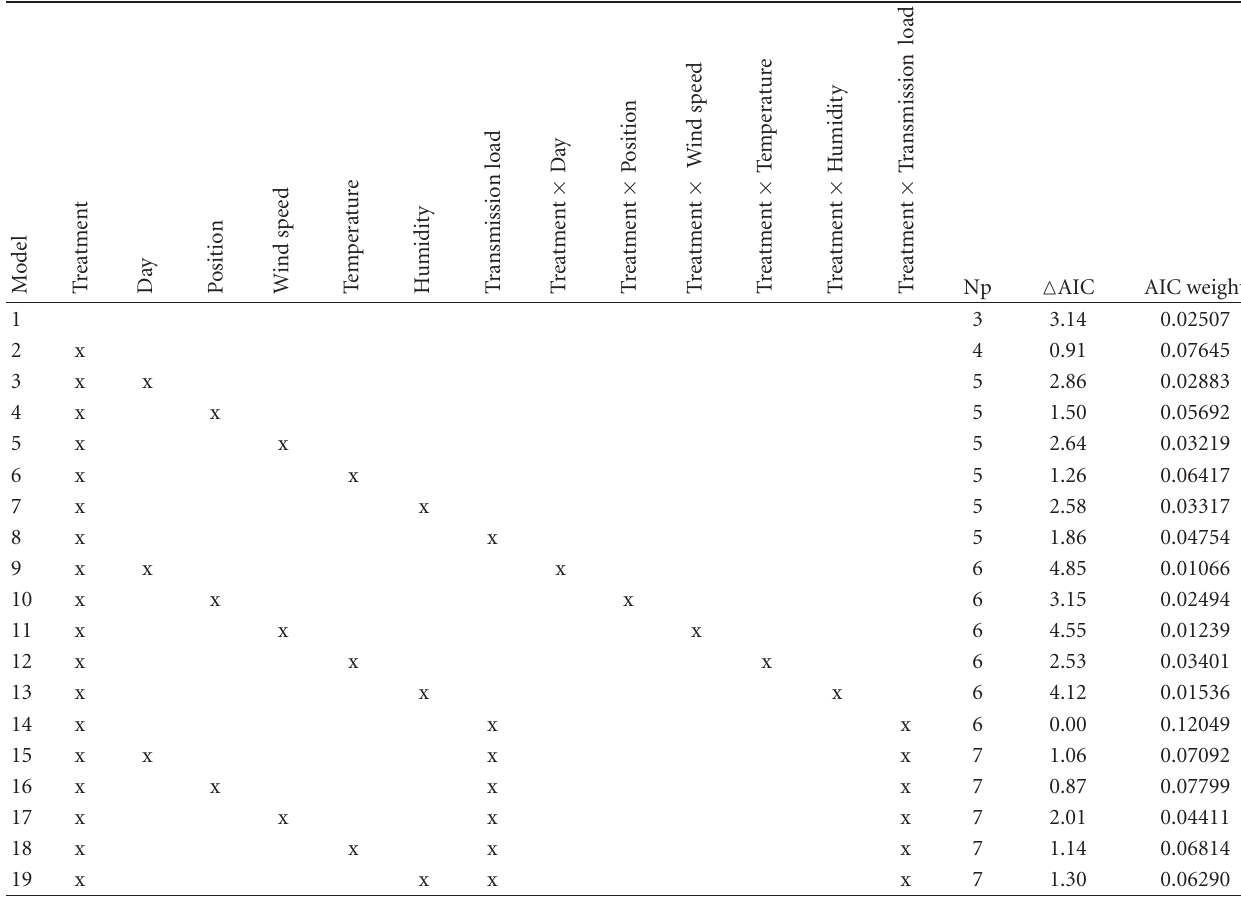
Table 7: Results from model selection on number of activity changes/minute among domestic tame animals using the AIC criterion (Np is number of